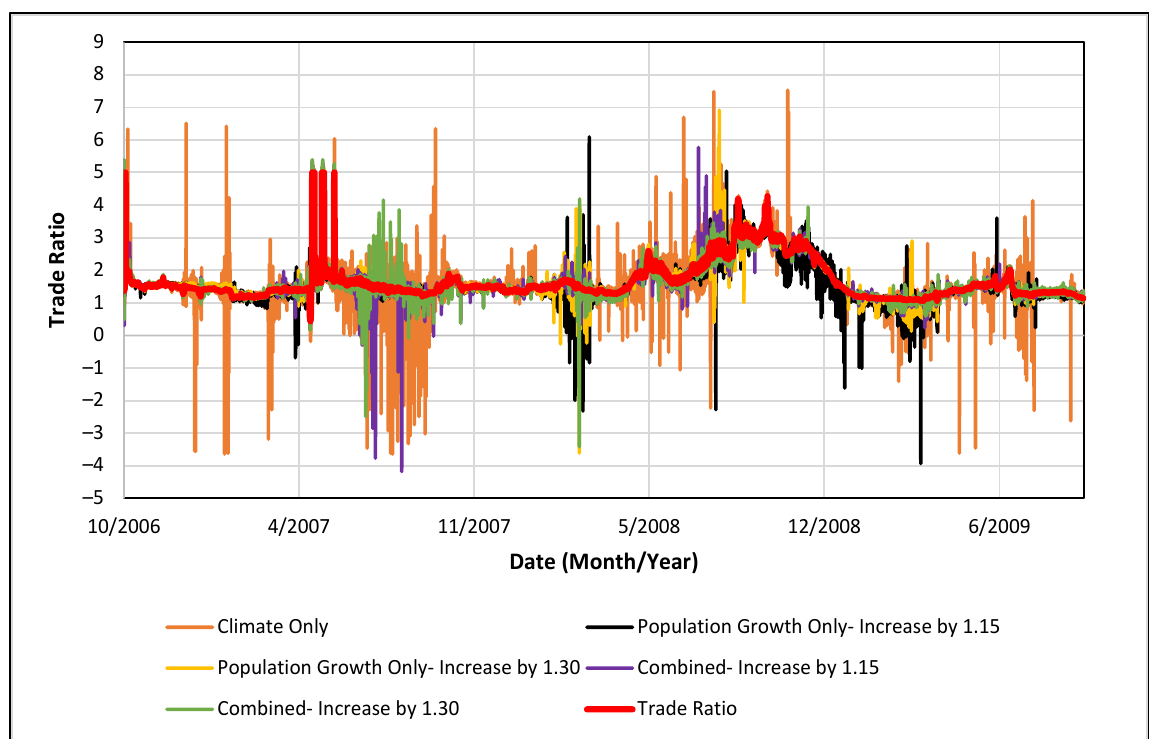
Figure 7. Composite Trade Ratio based on Sums for Delivery + Downstream Components with Equivalency Adjustments for Theoretical WQT Buyer TN Combined with Suggested Margins of Safety for Climate and Population Characteristics over the Jordan River Simulation Period (1 October 2006 to 30 September 2009) for RCP 6.0.